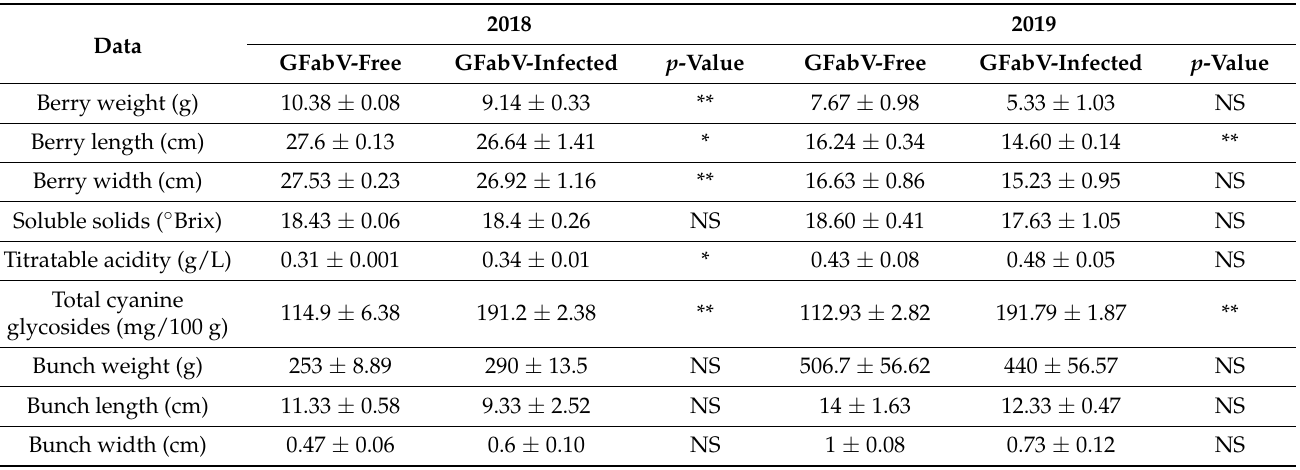
Table 1. Agronomic traits and Fruit quality indicators of GFabV-infected and GFabV-free of ‘Sum mer Black’ grapevines in two consecutive